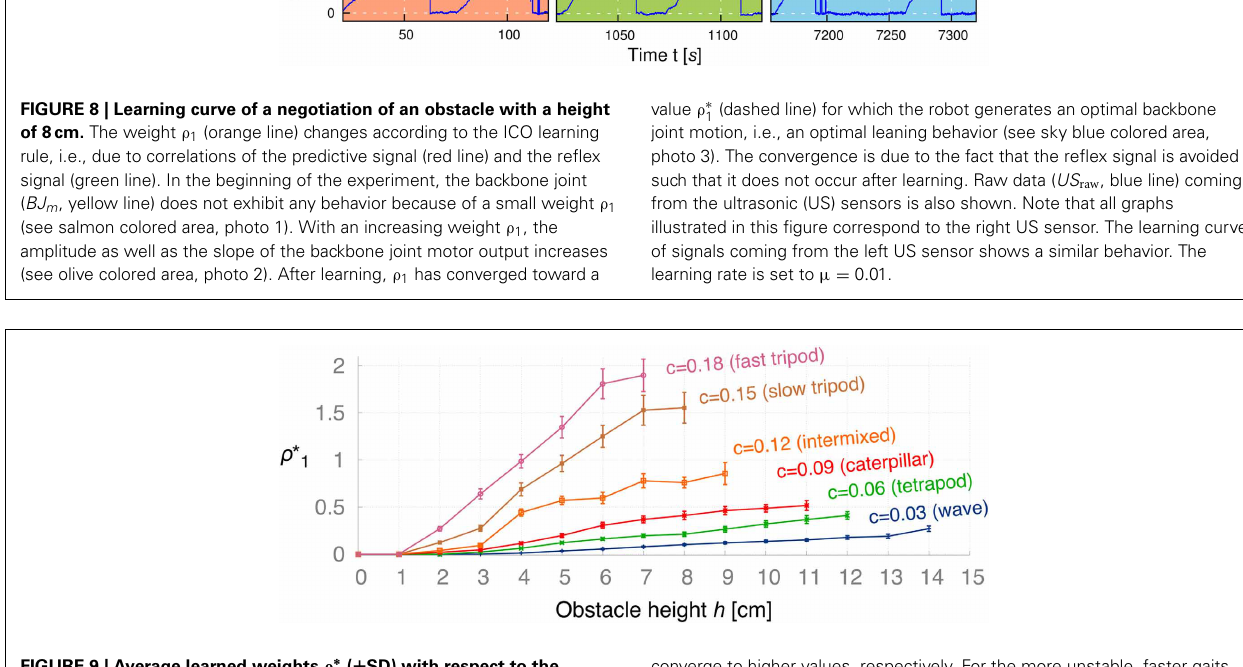
converge to higher values, respectively. For the more unstable, faster gaits the learning algorithm does not converge due to instabilities during climbing. However, these non-convergences correspond to the maximum obstacle height that the robot is able to achieve for given gaits (see Figure 12 ).